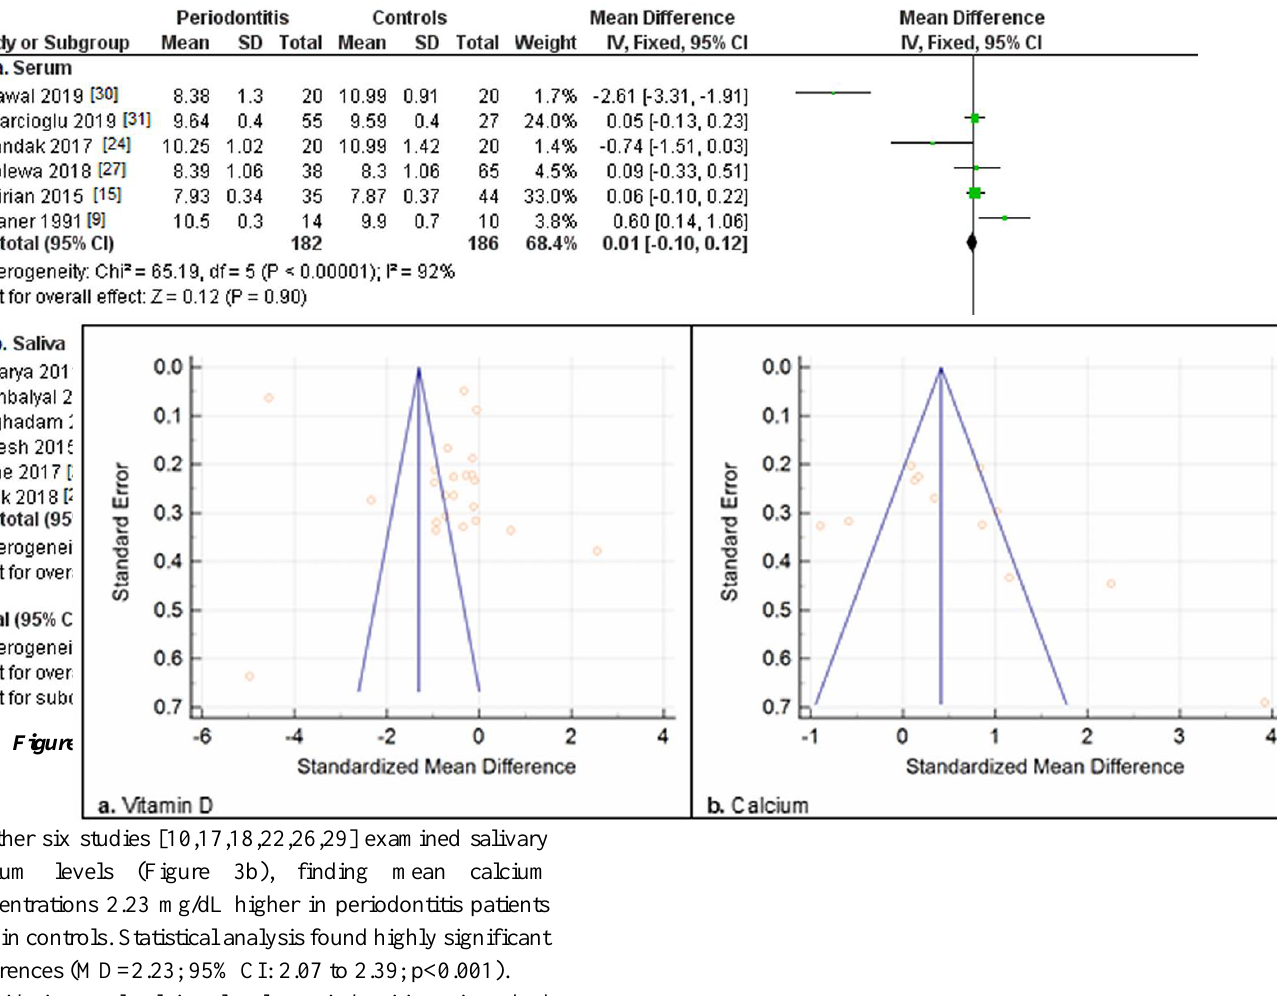
Figure 4: Funnel plots for assessment of publication bias between vitamin D (a) and calcium (b) levels and